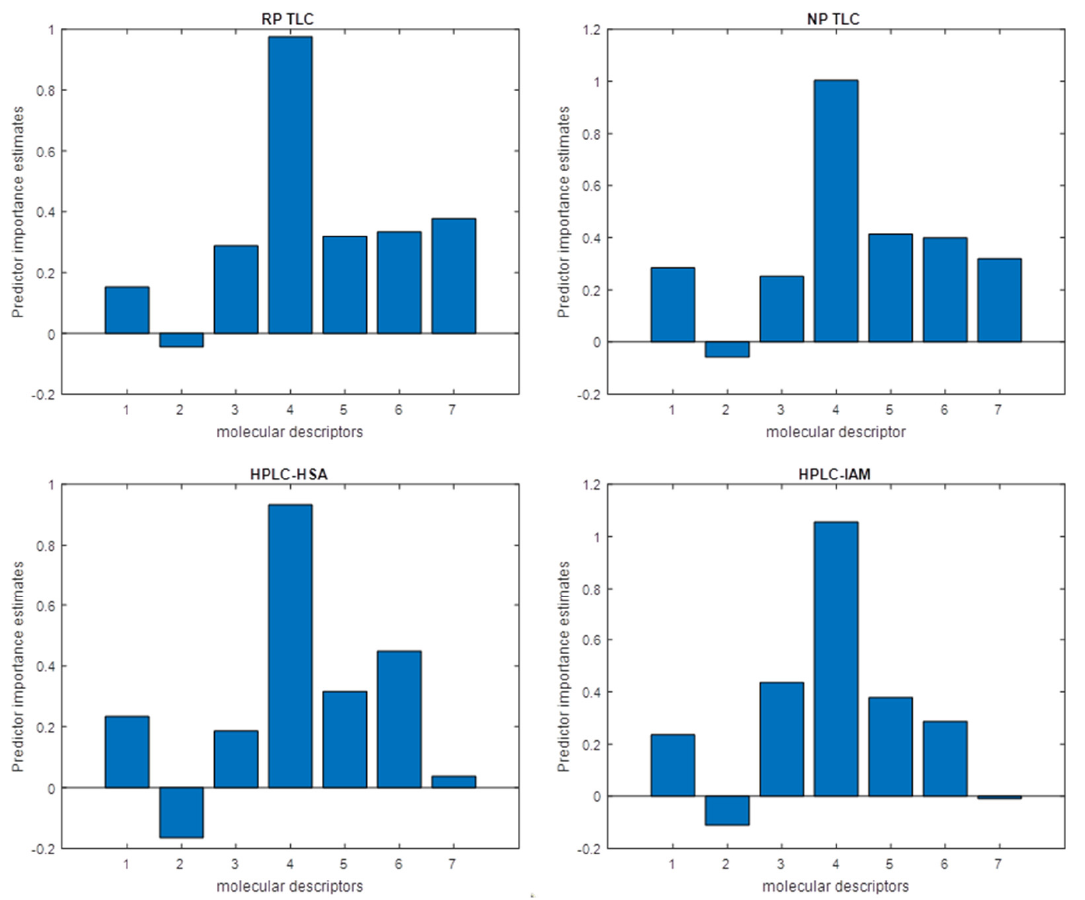
Figure 2. Model predictor importance plots. MDs are listed in accordance with Table 5. MD no. 7 is the value obtained in chromatographic experiments: R f or log k.